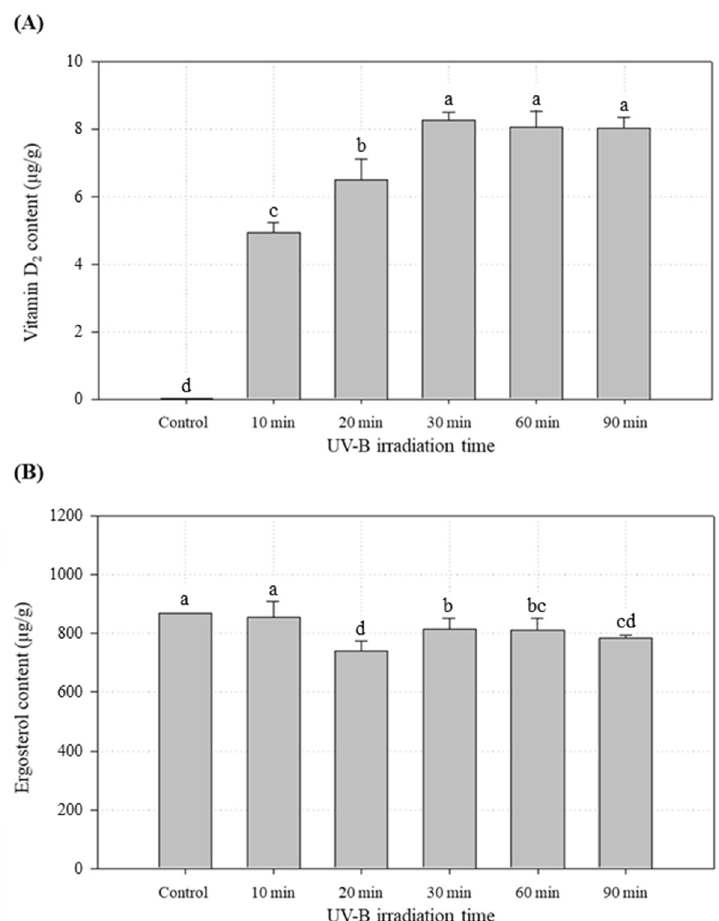
Figure 2. Effect of UV-B irradiation on the vitamin D 2 ( A ) and ergosterol ( B ) concentrations in white button mushrooms. All values are expressed as the mean ± standard deviation of triplicate analyses. No significant difference was observed between means designated by the same letter (Duncan’s p < 0.05).